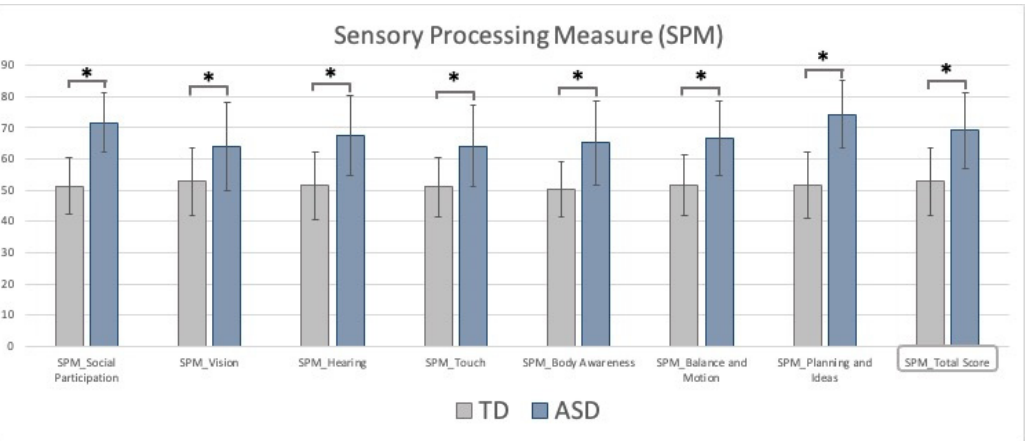
Figure 2. SPM-2 subscale and total score for TD (grey) and ASD (blue) groups. Bars indicate the standard deviations; asterisks indicate the statistical significance.